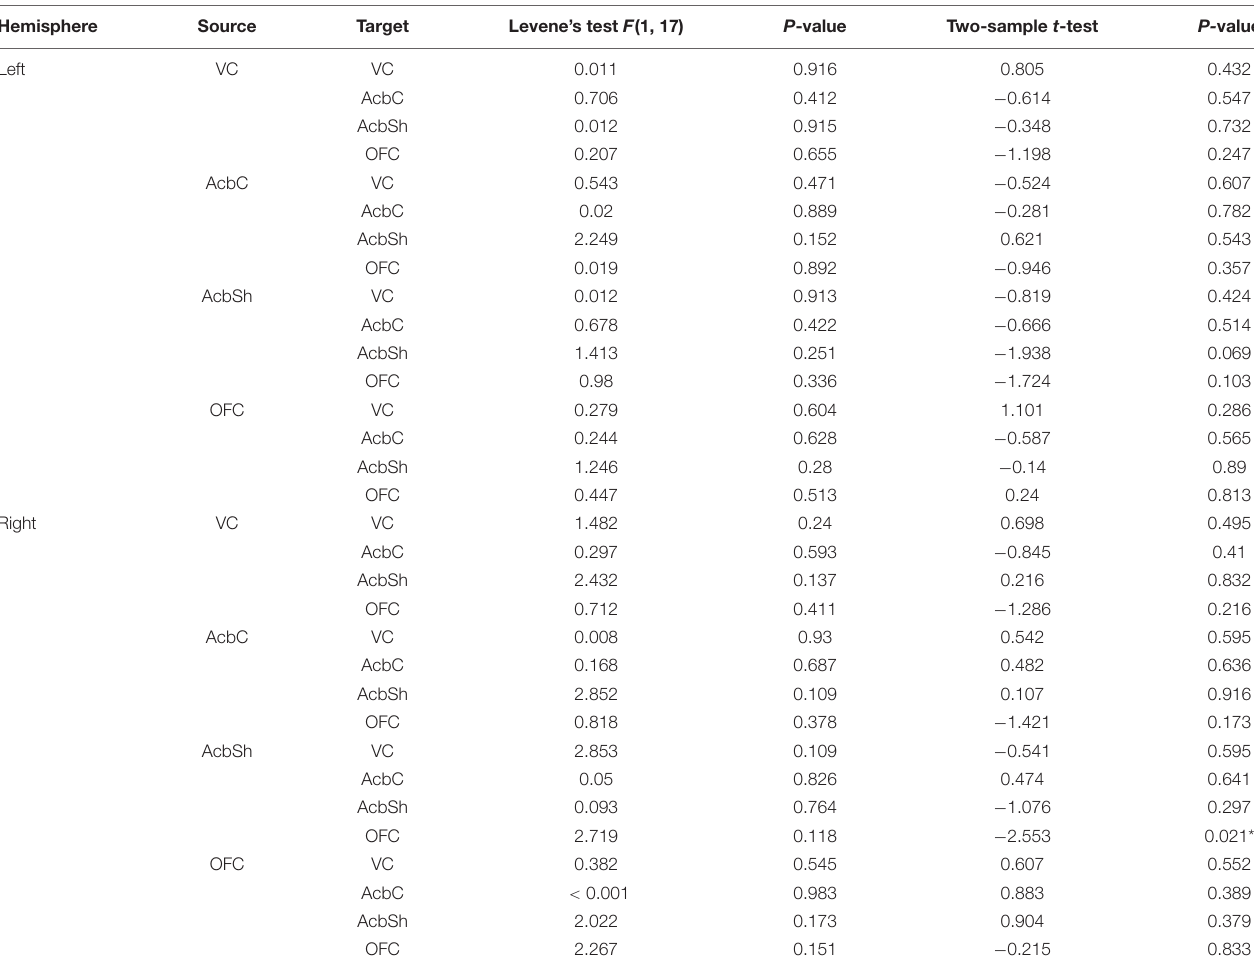
TABLE 1 | Comparisons of EC between MAM-sham and vehicle-sham groups.